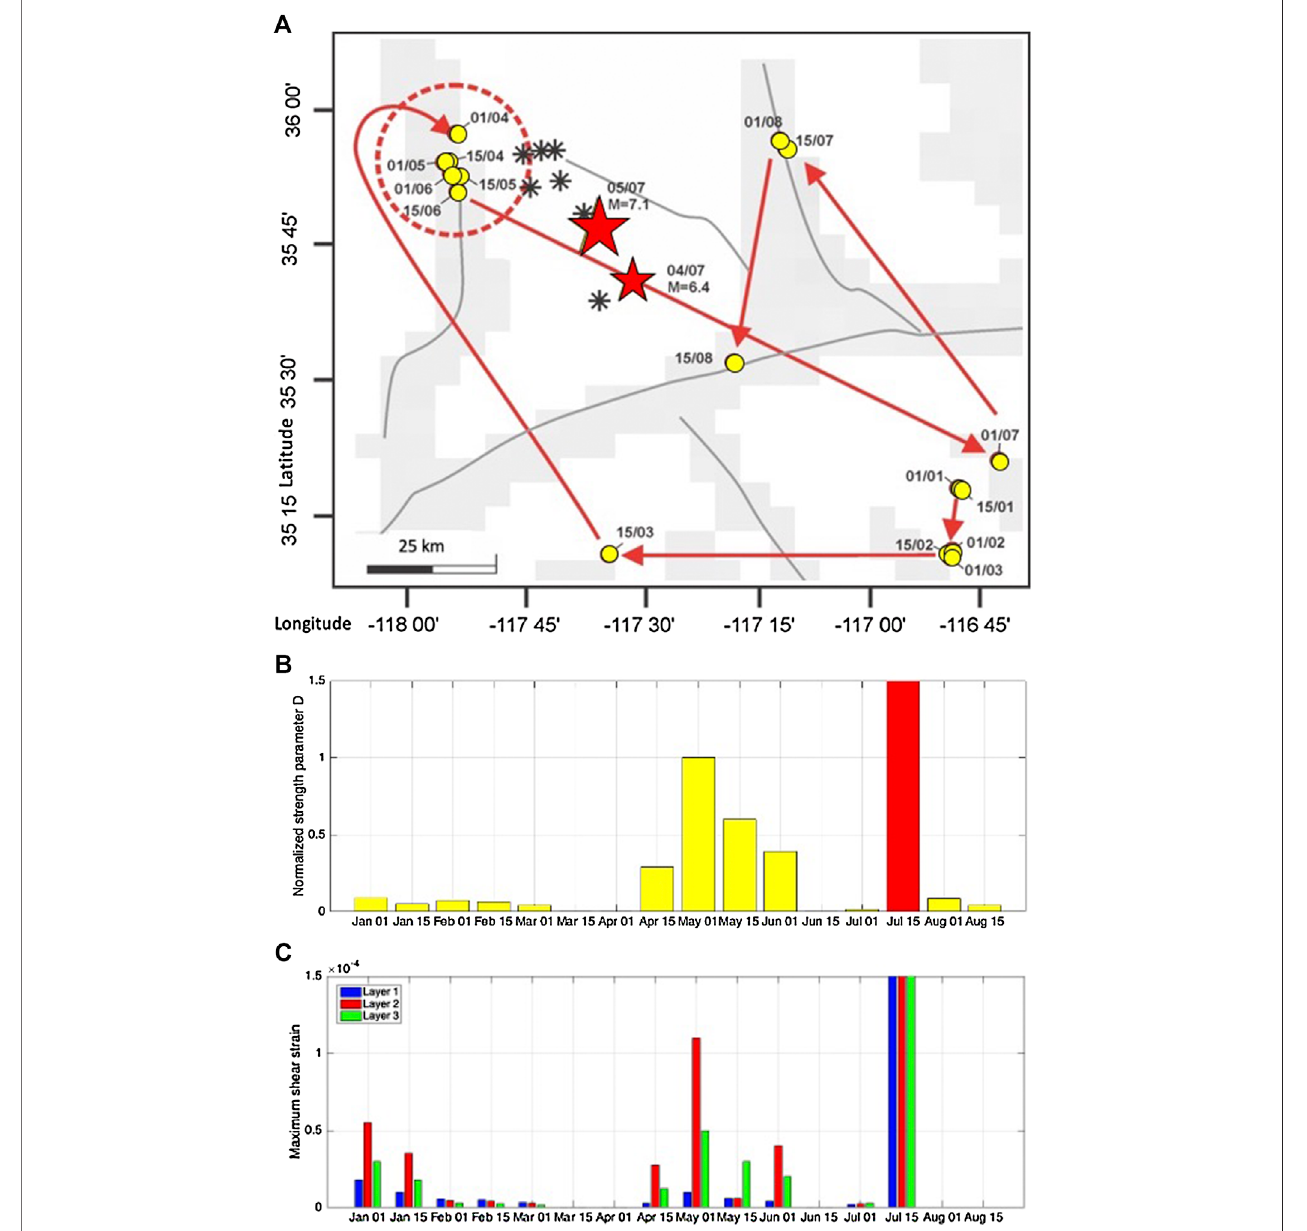
FIGURE 11 | (A) Migration path of the strength parameter D maximum (yellow circles), as it is approaching the future epicenters of the M 6.4 and M 7.2 Ridgecrest earthquakes (red stars) during January – July 2019. Gray-colored regions indicate zones of elevated rock damage. Red dashed circle indicates the region where the maximumstaysforasigni fi cantlylongperiodover2 months,whichisidenti fi edasaprecursor; (B) variationinthenormalizedmaximumstrengthparameter D ,calculated over the epicentral subdomain during January – August 2019; (C) plots of the maximum shear strain absolute values calculated for the three upper layers of the earth ’ s crust during January – July 2019, prior to the M 7.1 Ridgecrest